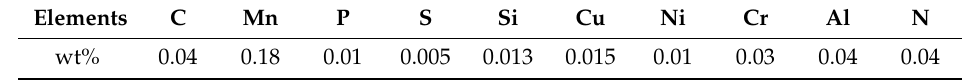
Table 1. Chemical analysis of the steel substrate.